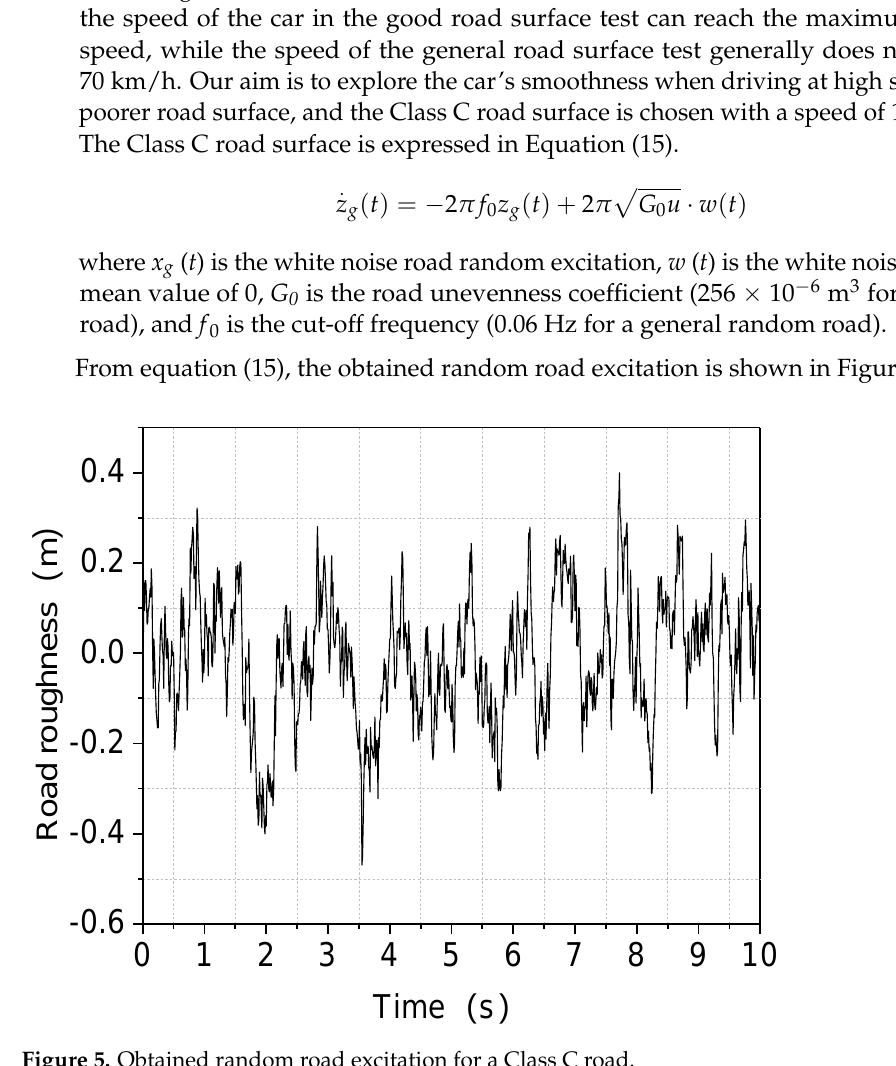
Figure 5. Obtained random road excitation for a Class C road.